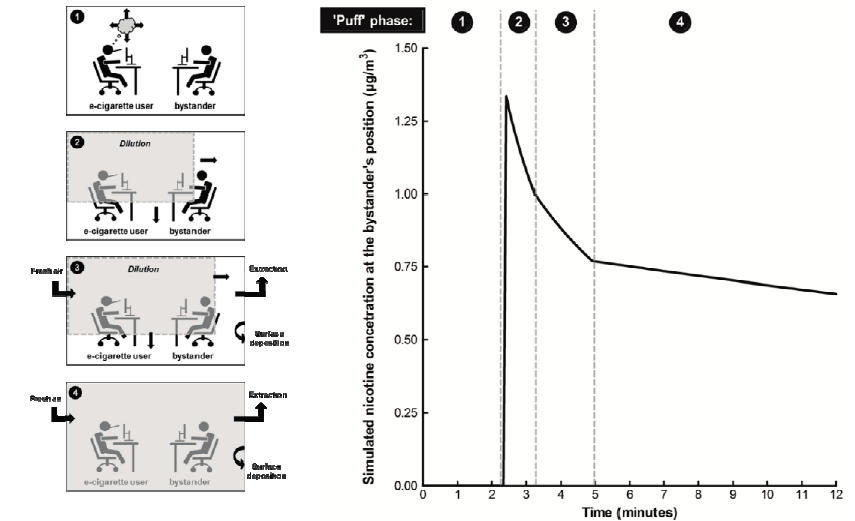
Figure 1. Phases of bystander exposure to exhaled vapour after a single “puff”. Phase 1